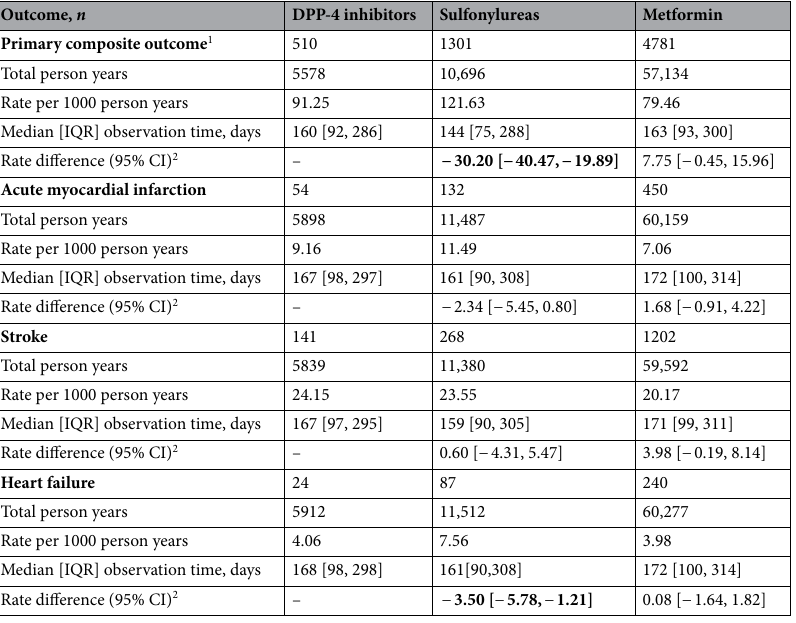
Table 2. Incidence rates of primary composite outcome, acute myocardial infraction, stroke, and heart failure among new users of DPP-4 inhibitors, sulfonylureas, and metformin. IQR interquartile range. 1 Primary composite outcome includes myocardial infarction, cardiac arrest, coronary artery bypass, coronary angioplasty, heart failure, stroke, inpatient death. 2 Incidence rate difference per 1000 person-years. Bold values indicate statistically significant